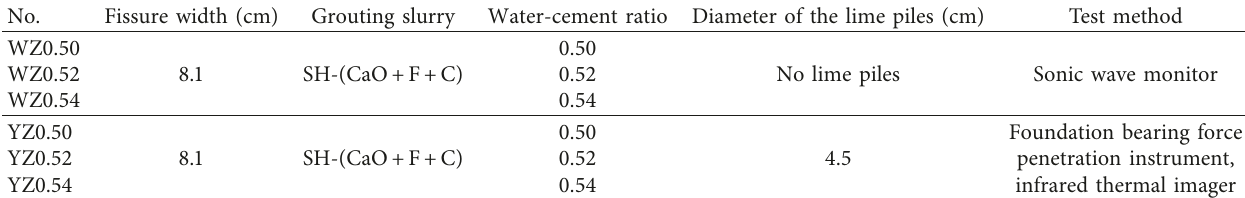
Table 3: Fissure grouting field experiment